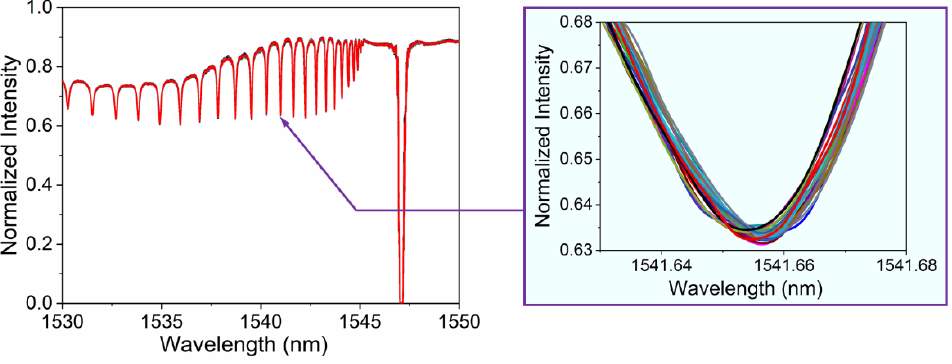
Figure 4. Spectral change of cladding mode resonance near 1541.6 nm for 50 min in buffer.